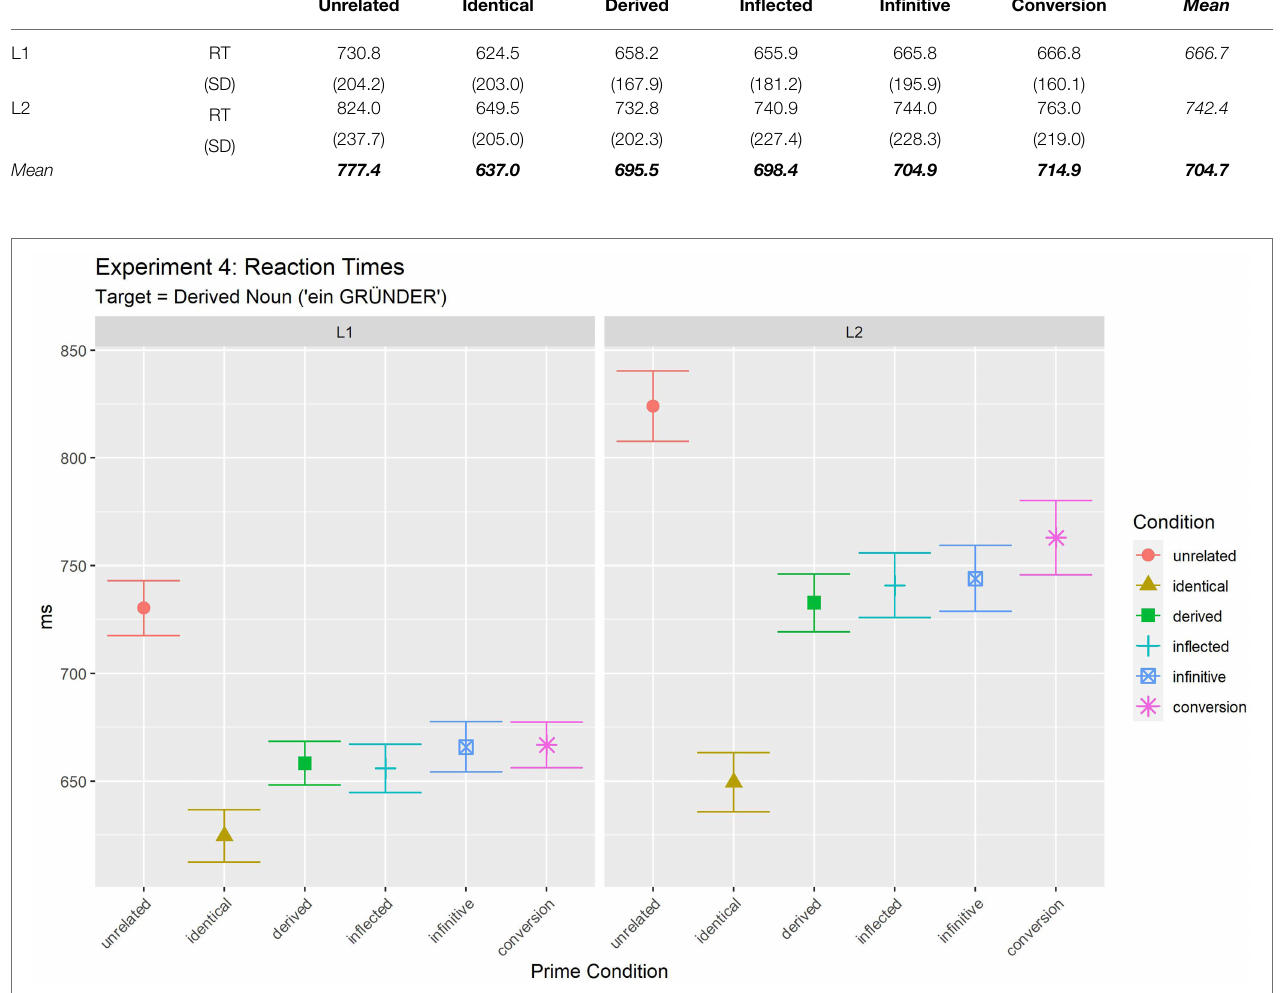
FIGURE 4 | Experiment 4 (target: derived noun): mean reaction times for target phrases.